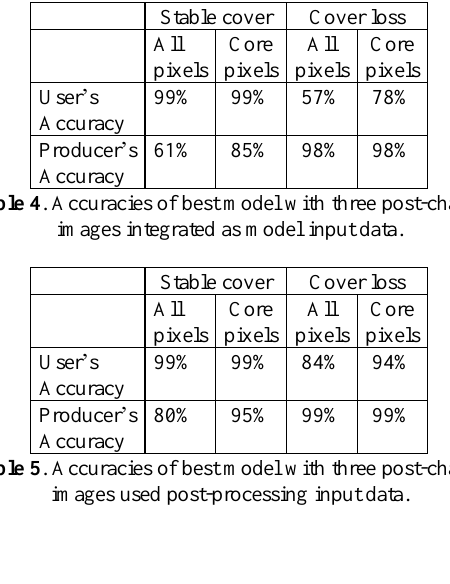
Figure 1 . Best NN